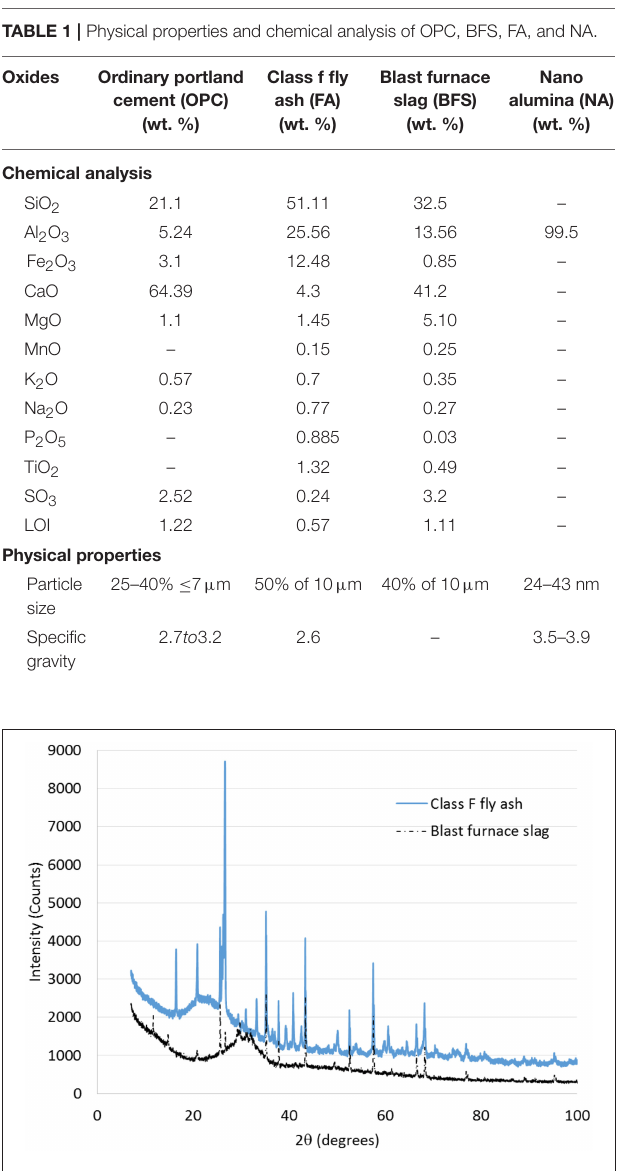
FIGURE 1 | XRD analysis of class F fly ash and blast furnace